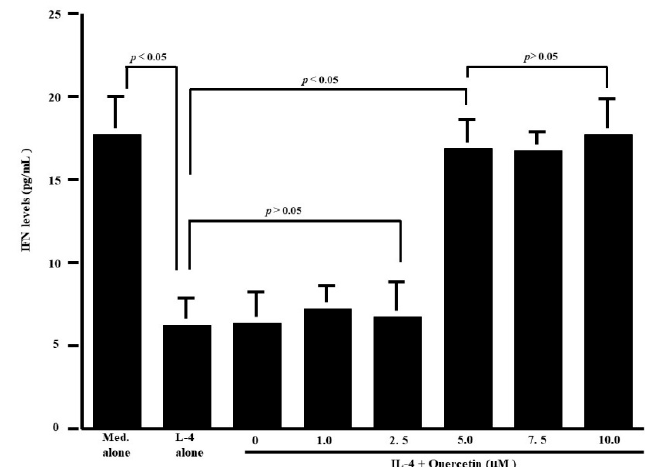
Figure 2. Influence of quercetin on interferon (IFN)- γ production from human peripheral-blood CD4 + T cells in vitro. CD4 + T cells (1 × 10 6 cells/mL) were stimulated with 10.0 ng/mL IL-4 in the presence of various concentrations of quercetin for 24 h. IFN- γ levels in culture supernatants were examined by ELISA. The results were expressed as the mean pg/mL ± SE of five subjects.